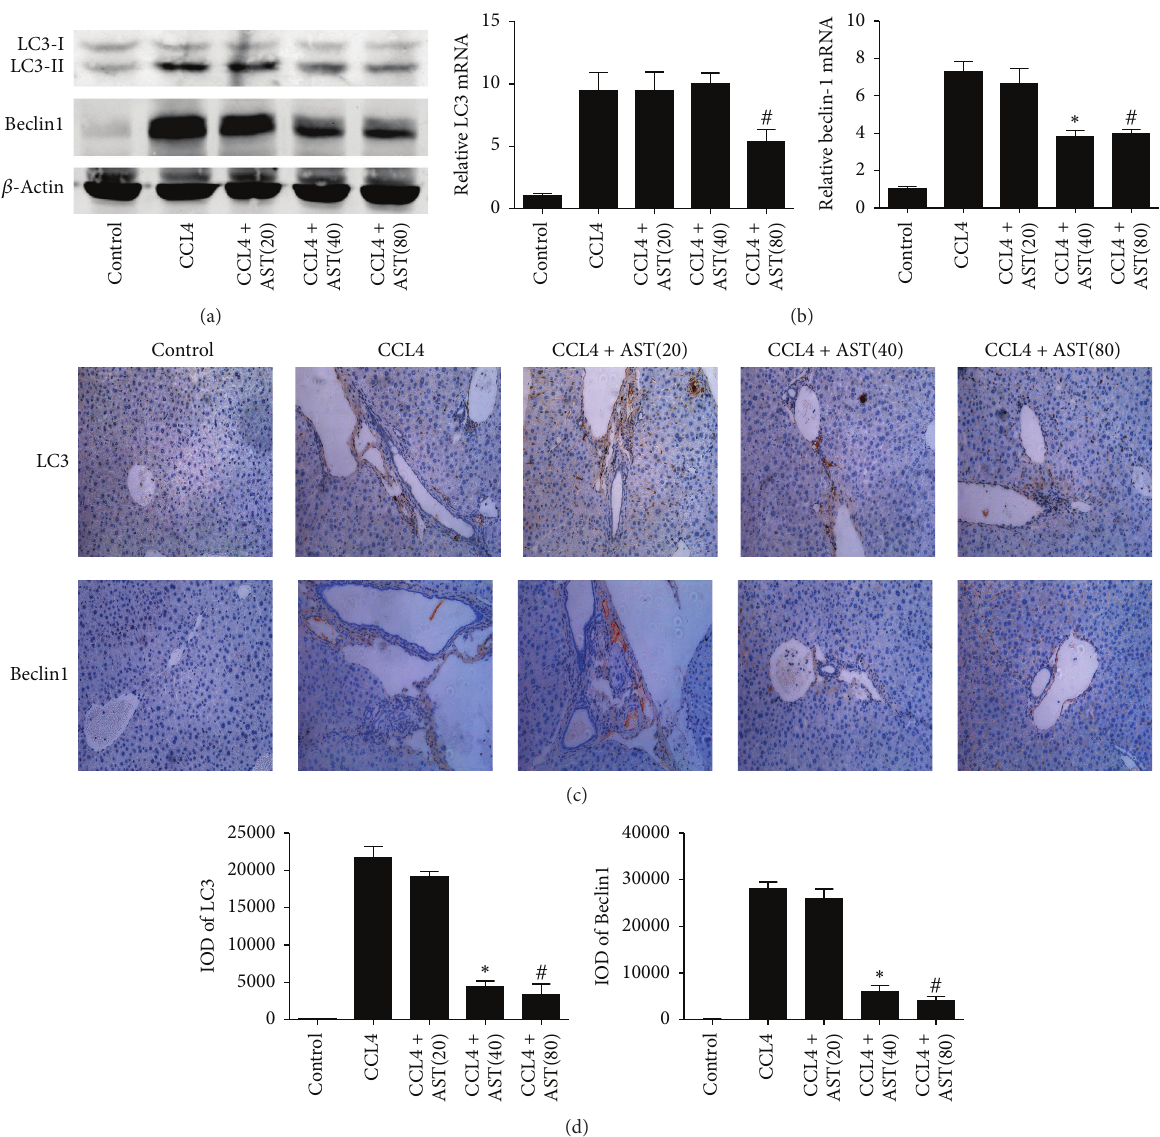
Figure5:EffectofastaxanthinontheregulationofautophagyinHSCs.(a)Theanalysisofwesternblottingshowedthatastaxanthin(40 mg/kg and 80 mg/kg) obviously decreased the expression of LC3-II and beclin-1. (b) The mRNA levels of beclin-1 were decreased by astaxanthin (40mg/kg and 80 mg/kg) compared to CCL4 group, and the level of LC3 was decreased only with the dose of 80 mg/kg. Data are expressed as mean ± SD ( 𝑛 = 7 , ∗ 𝑃 < 0.05 for CCL4 + AST(40) versus CCL4, # 𝑃 < 0.05 for CCL4 + AST(80) versus CCL4). (c) The areas of positive cells of LC3 and beclin-1, mainly expressed in HSCs as showed, were visibly diminished by astaxanthin (40 mg/kg and 80 mg/kg) (original magnification: ×200 ). (d) The IODs of LC3 and beclin-1 were analyzed by Image-pro Plus 6.0. There existed a significant decrease with astaxanthin (40mg/kg and 80 mg/kg) treatment ( 𝑛 = 7 , ∗ 𝑃 < 0.05 for CCL4 + AST(40) versus CCL4, # 𝑃 < 0.05 for CCL4 + AST(80) versus